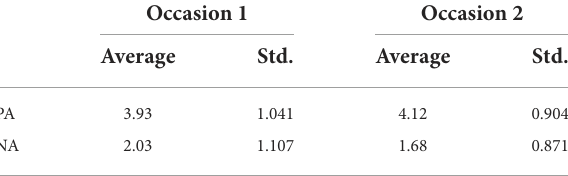
TABLE 2 Statistics of the affective